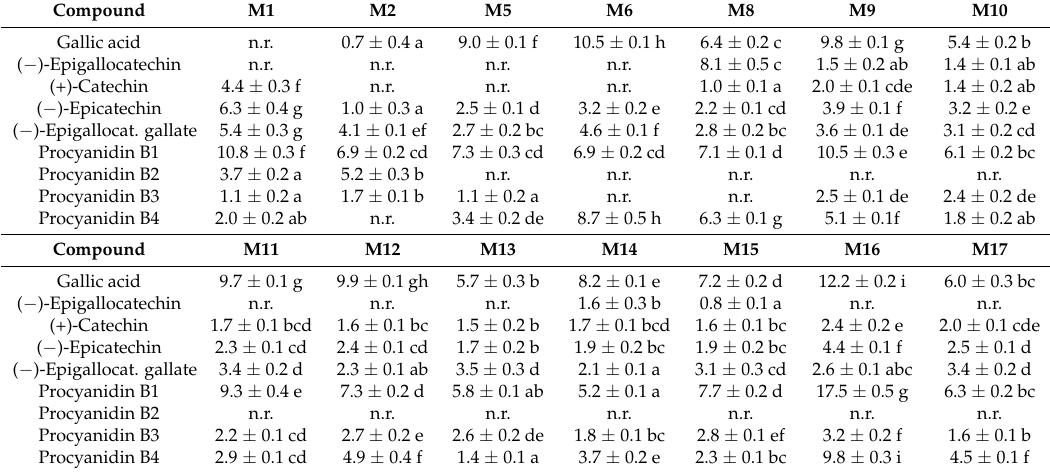
Table 4. Gallic acid, flavanols and oligomeric proanthocyanidins content of berry skins (mg/kg of grape, expressed as (+)-catechin). Values represent mean of three replicates ± SD. a, b, c: the means that do not bear a common letter differ significantly at the 0.05 level of significance.